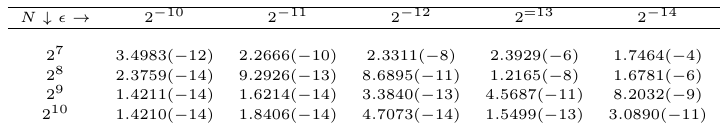
Table 6. Maximum absolute errors in the solution of Example 3 for µ = 2 −